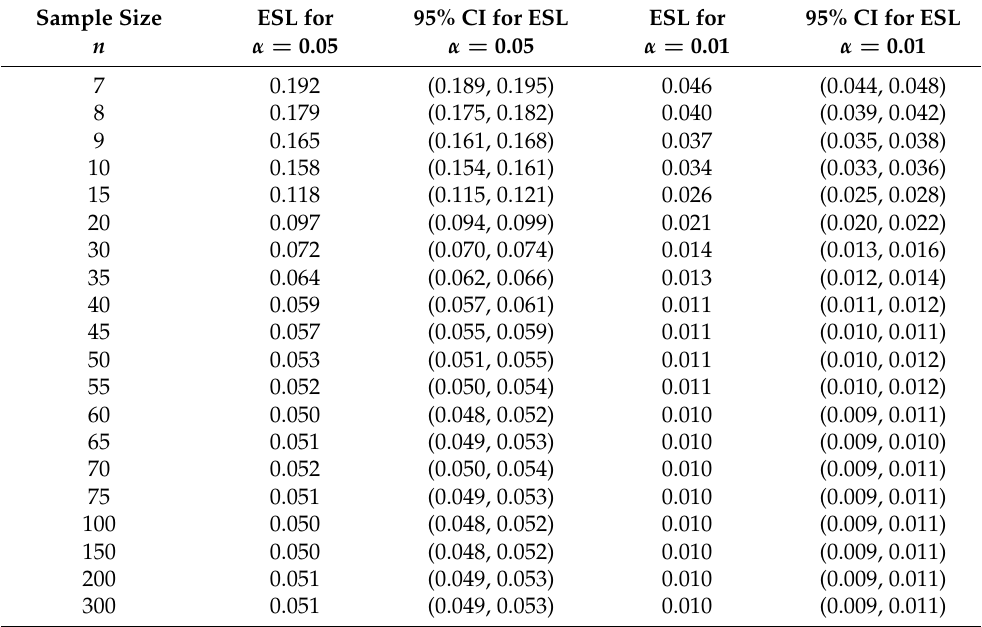
Table 1. ESLs with asymptotic 95% CIs of the supremum test statistic for various sample sizes when d = 3 and the NSLs are equal to 0.05 or